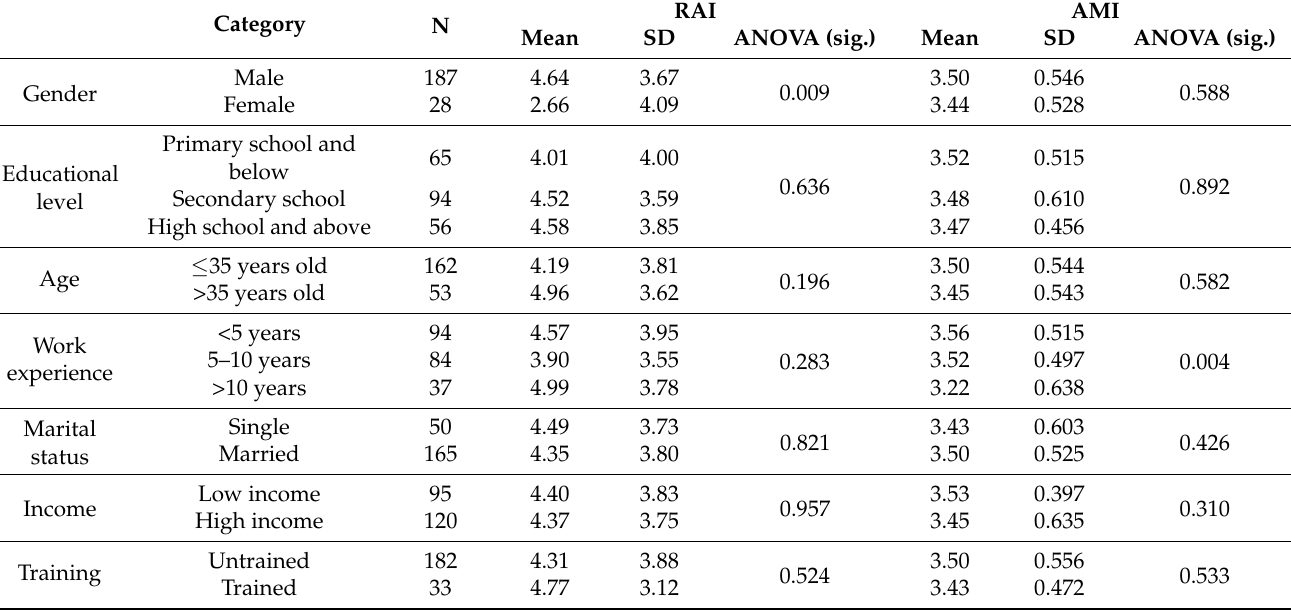
Table 4. Measuring the autonomy of workers